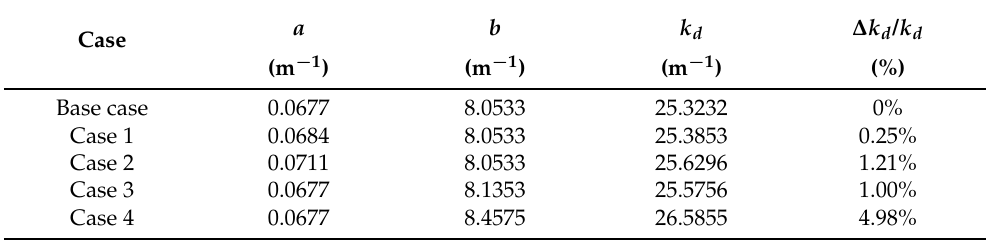
Table 2. Changes of the attenuation coefficient in response to changes of the absorption coefficient and the backscattering